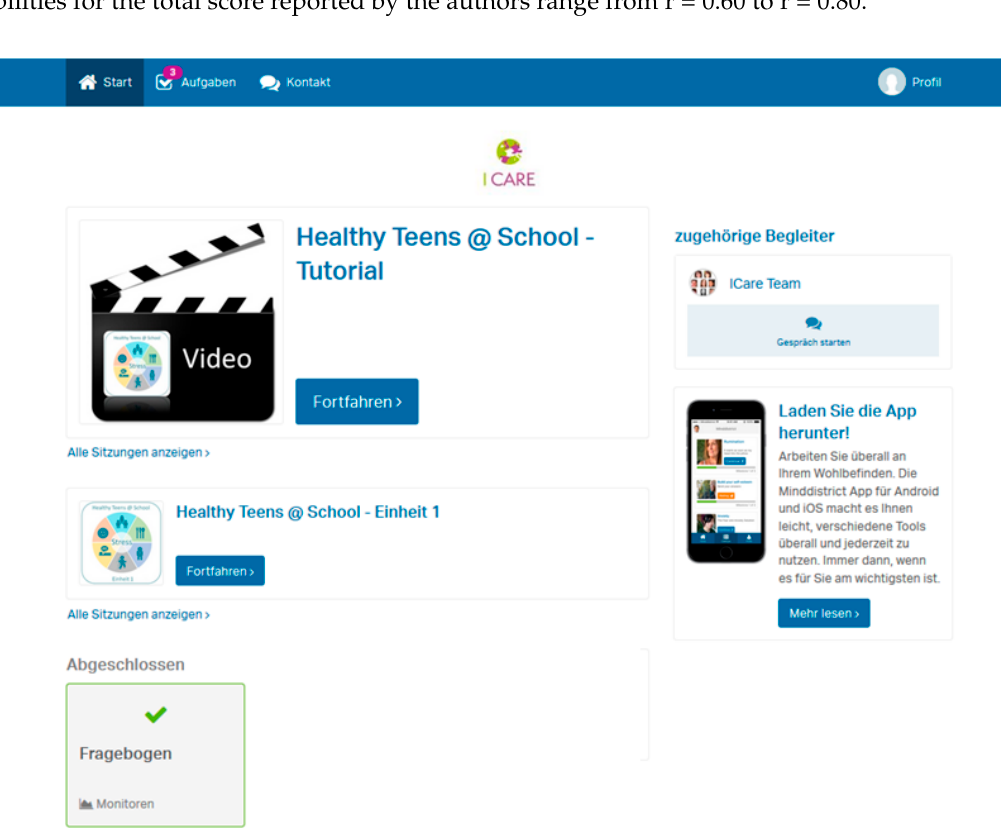
Figure 1. Screenshot of the user’s dashboard on the online platform.